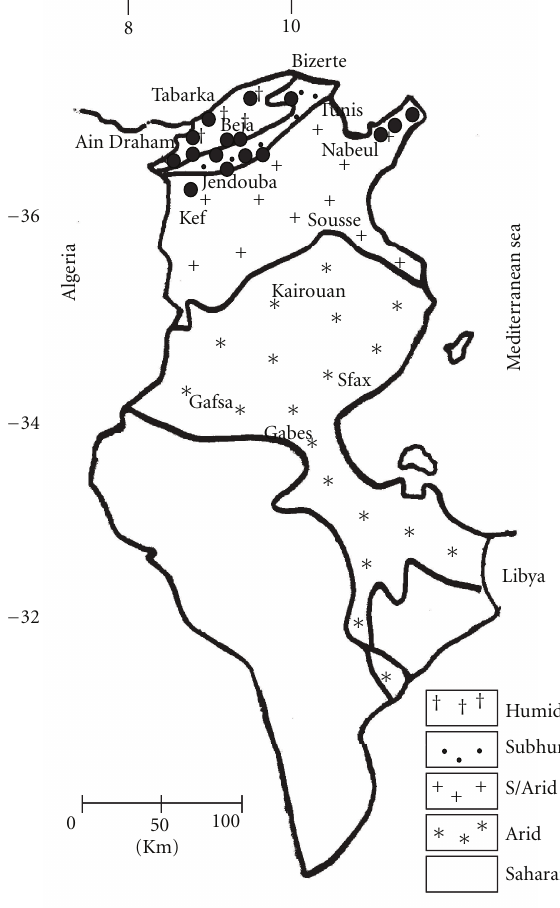
Figure 1: Map of Tunisia showing collection sites • of tall fescue.